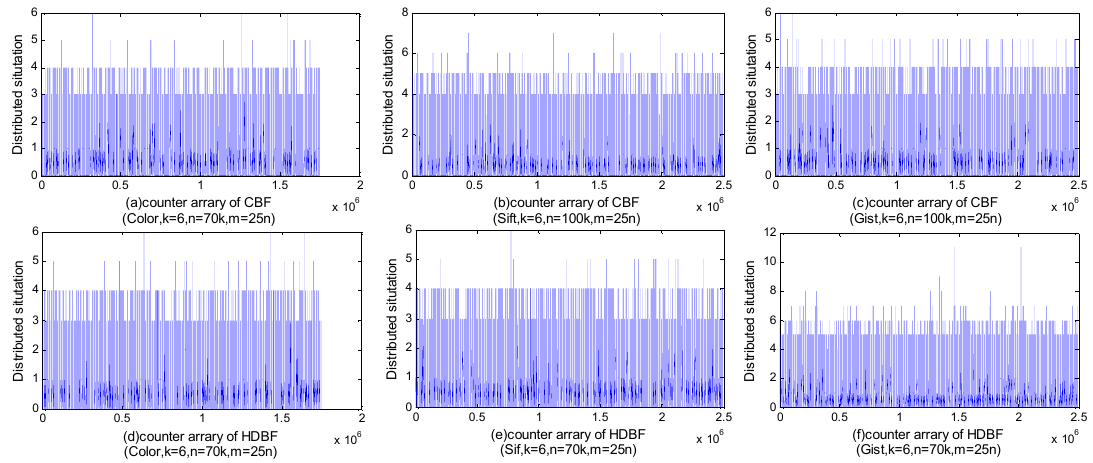
Figure 3. The distributions of CBF and HDBF for different samples.